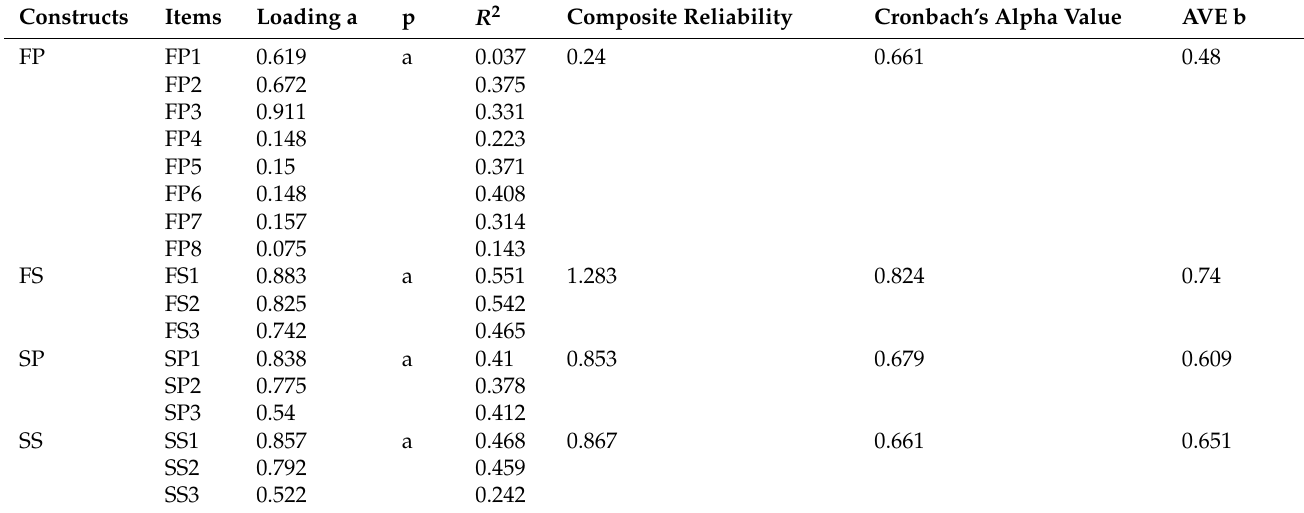
Table 3. Confirmatory factor analysis (CFA) results for measurement